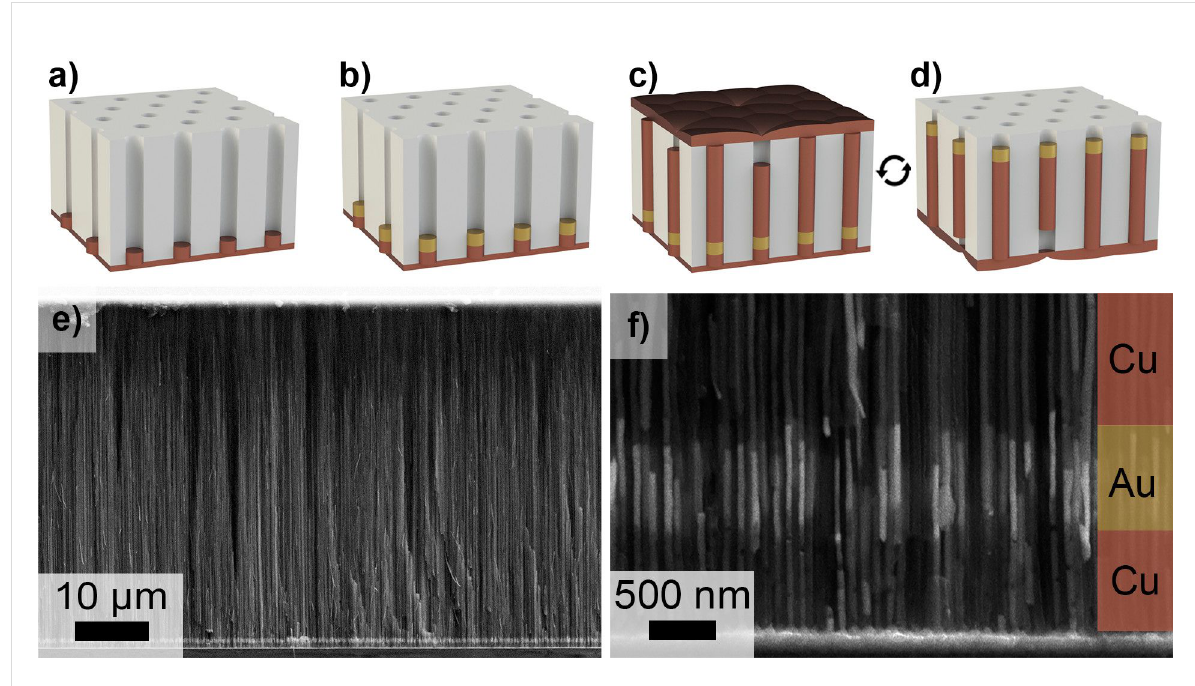
Figure 1: The flow chart of the NEA preparation: (a) deposition of Cu current collector and subsequent electrodeposition of the first Cu segment; (b) electrodeposition of the second Au segment; (c) electrodeposition of the third Cu segment until the formation of a continuous Cu layer on the sur- face of AAO template; (d) turning the AAO template upside down with subsequent selective dissolution of the current collector and the first Cu seg- ment. Cross-sectional SEM images of AAO/Cu/Au/Cu nanocomposite, schematically shown in panel (c), illustrating the full thickness of the template (e) and the bottom part with two short segments of Cu and Au